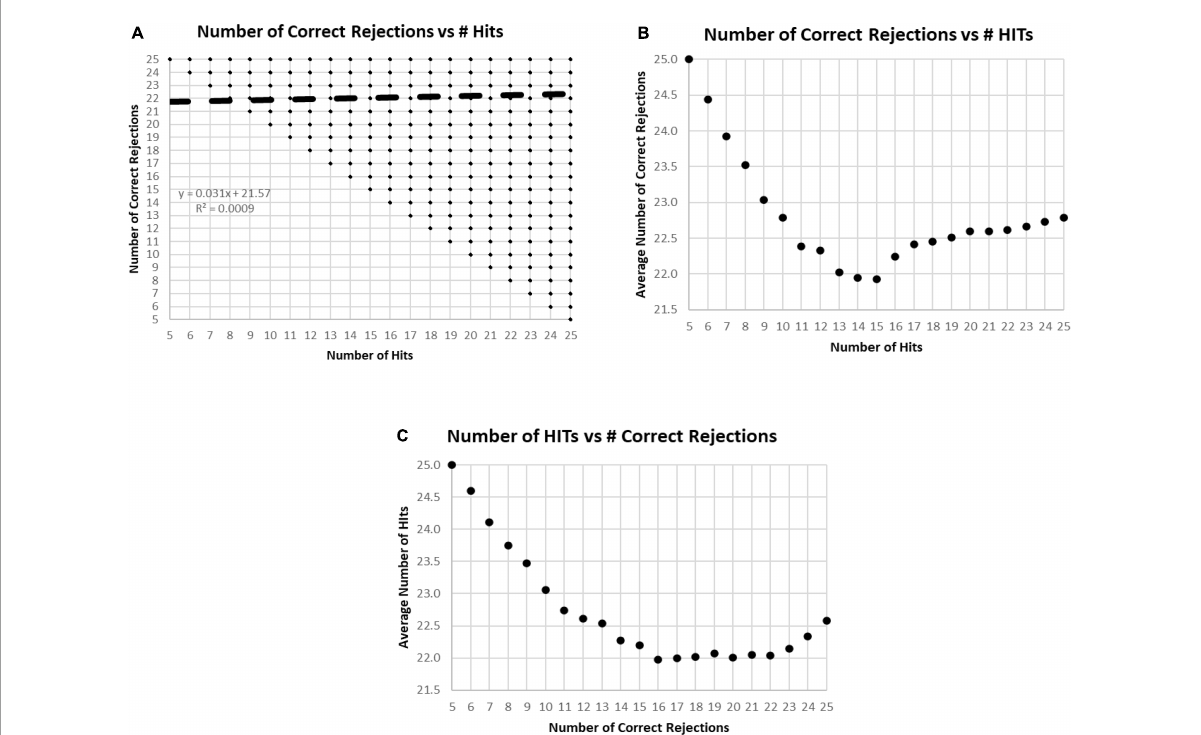
FIGURE5 (A) Plot of number of Correct Rejections versus number of HITs. The correlation showed essentially no relationship. Among the 282,140 tests, all 231 possible variations of responses were represented. The limitation of five HITs and five Correct Rejections was due to the limitation of the data set to those subjects with at least 60% correct, 30 correct responses. (B) Plot of average number of Correct Rejections versus number of HITs. Note the slow decrement of correct rejections with a decrease of HITs from 25 down to 17, at which point, there is a drop of correct rejections, but then below 15 HITs there appears to be a strategy to be more careful have more correct rejections. (C) Plot of average number of HITs versus number of Correct Rejections. Note the decrement of HITs from 25 to 22 Correct Rejection, then below 16 Correct Rejections, there is a sharp tendency to have more HITs, which appears to be a strategy to respond more, indiscriminately.